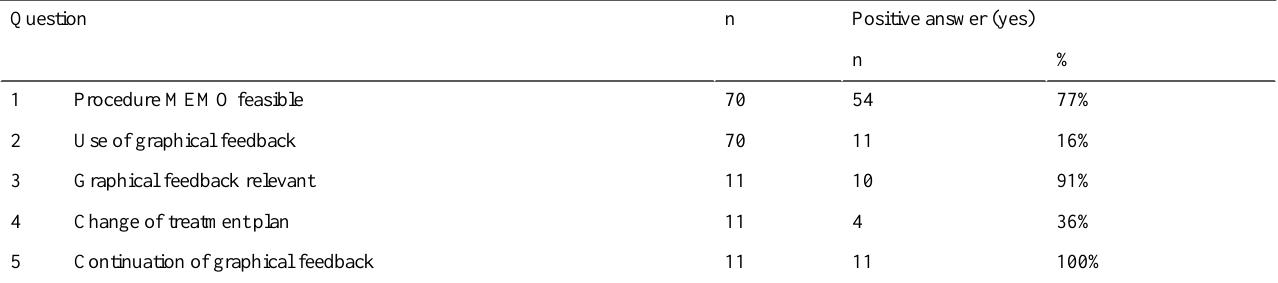
Table 2. Clinicians’answers to the yes-or-no questions on the feasibility of Mental Health Care Monitor Older Adults (MEMO) and the use of feedback from the Web-based